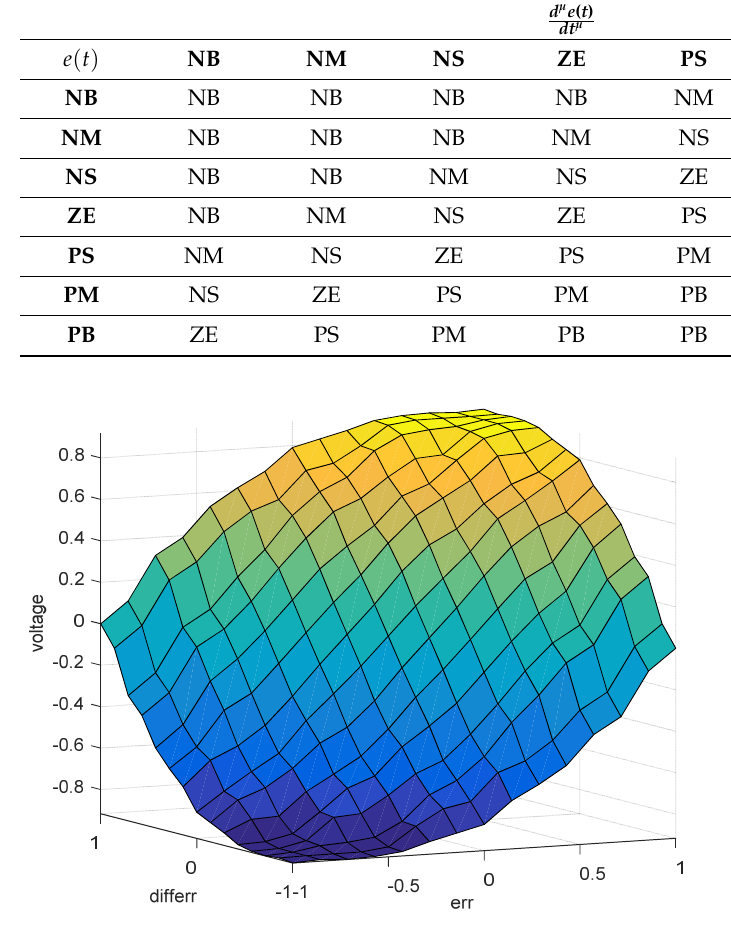
Figure 4. Surface view of fuzzy inference .